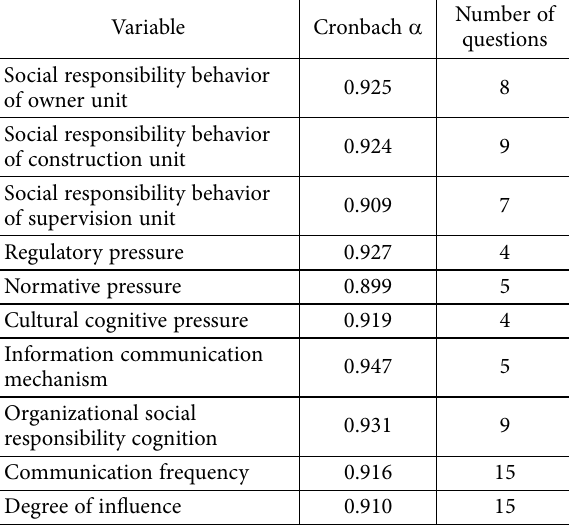
Table 5. Regression results for Model 1